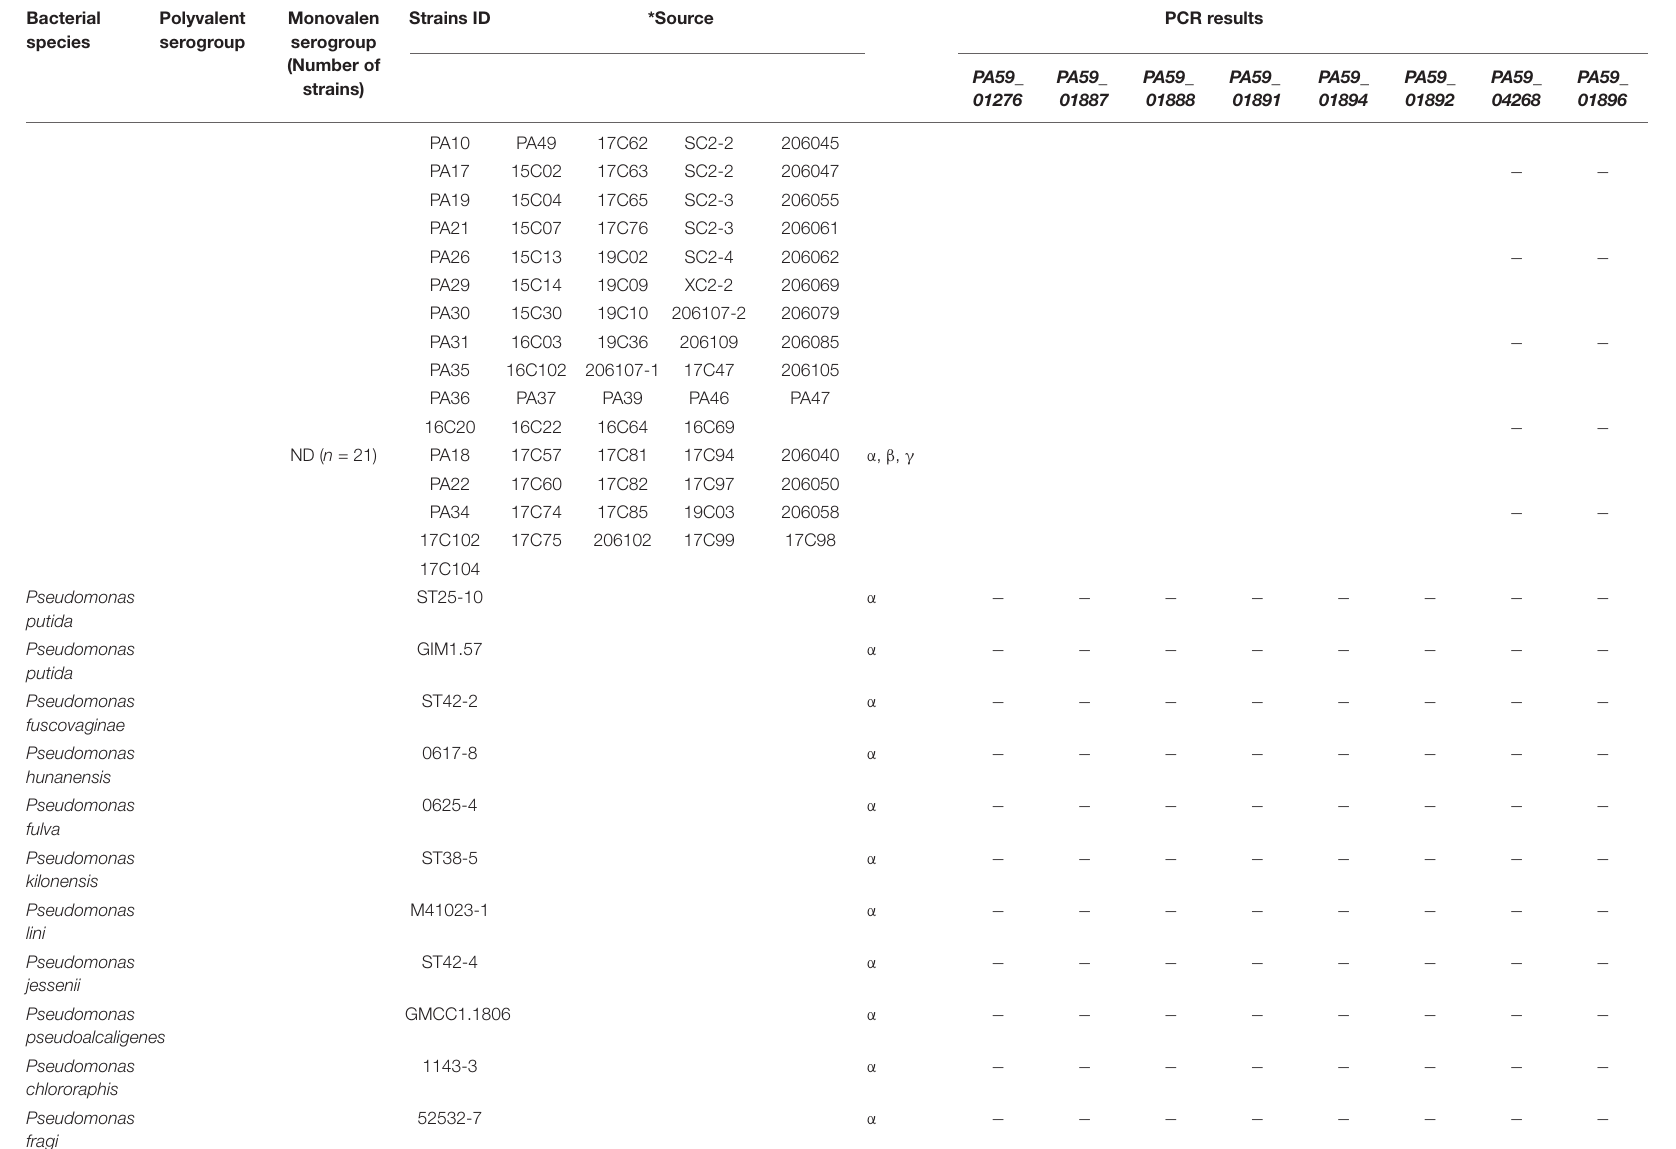
Pseudomonas pseudoalcaligenes Pseudomonas